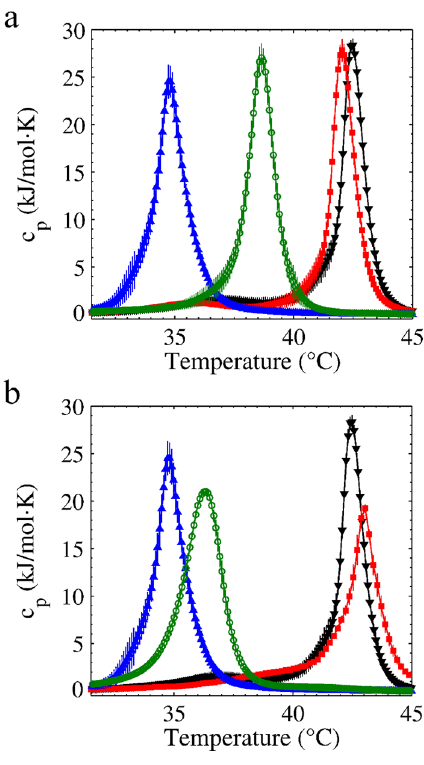
Figure 3. Calorimetric study of DPPC/DPPA liposomes. (a) Tetracaine-caffeine experiment: Triangles down are for the control sample, triangles up for 8 mM of tetracaine, squares for 111 mM of caffeine and circles for the combination 8 mM tetracaine-111 mM of caffeine. (b) Tetracaine-calcium experiment: triangles down are for the control sample, triangles up for 8 mM of tetracaine, squares for 200 mM of CaCl 2 and circles for the combination 8 mM tetracaine-200 mM of CaCl